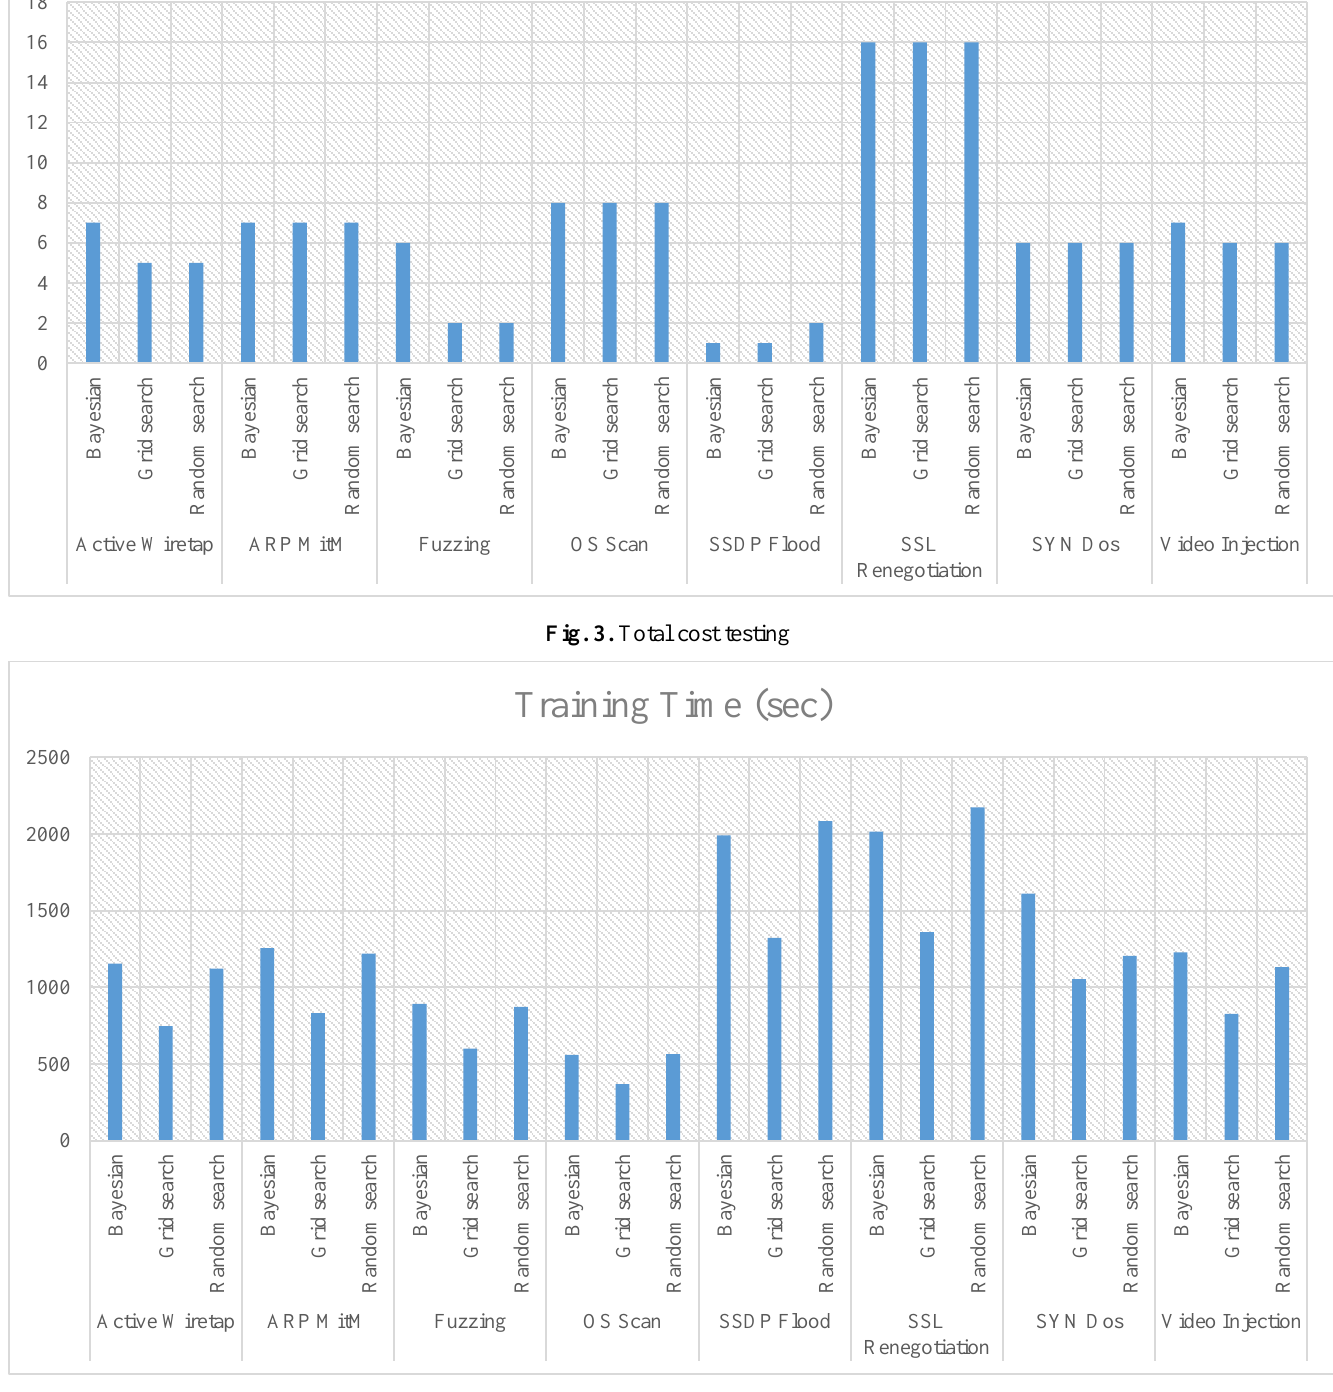
Fig. 4. Training time